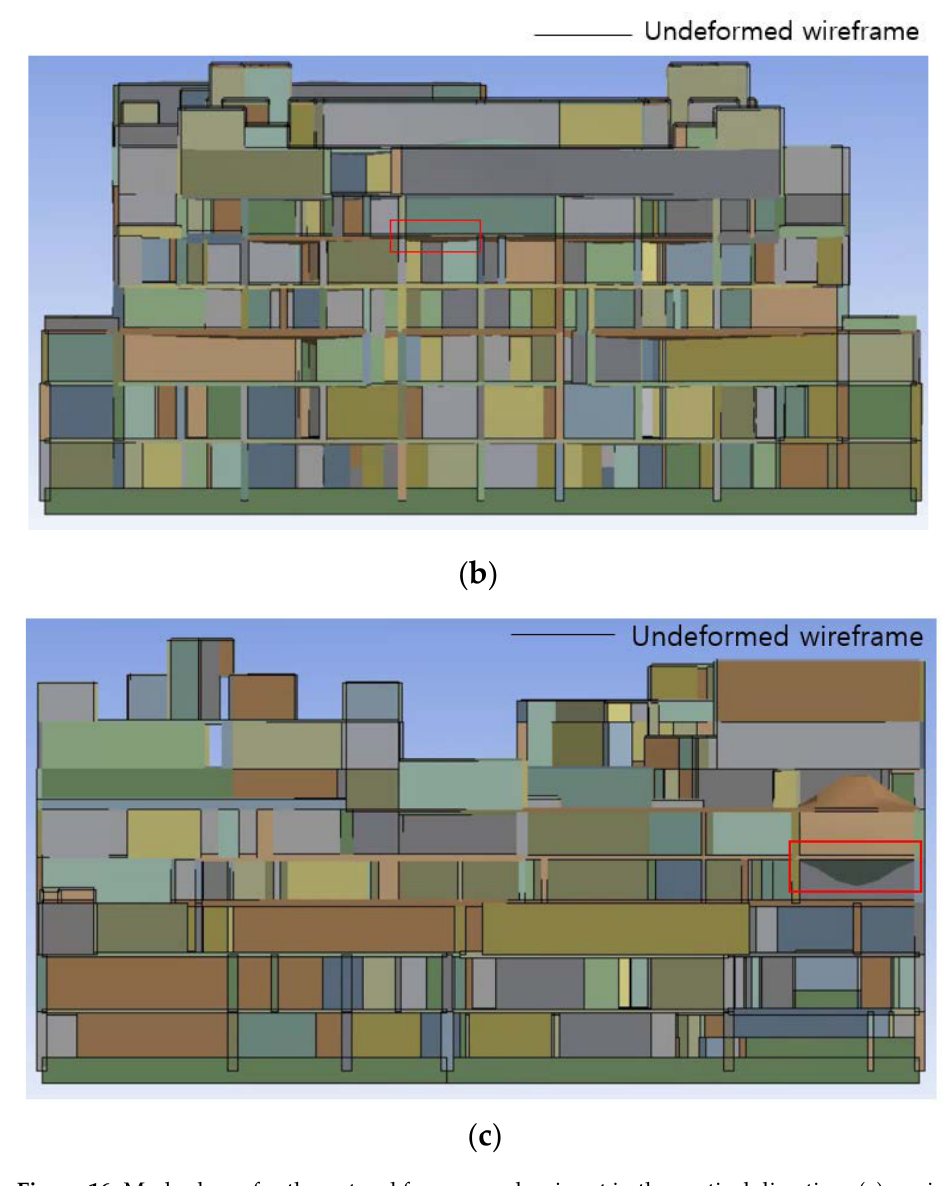
Figure 16. Mode shape for the natural frequency dominant in the vertical direction: ( a ) equipment location 1 (16.4 Hz); ( b ) equipment location 2 (14.4 Hz); ( c ) equipment location 3 (15.3 Hz). Table 4. Mass ratio of the equipment to the dominant mode for different equipment locations and directions.